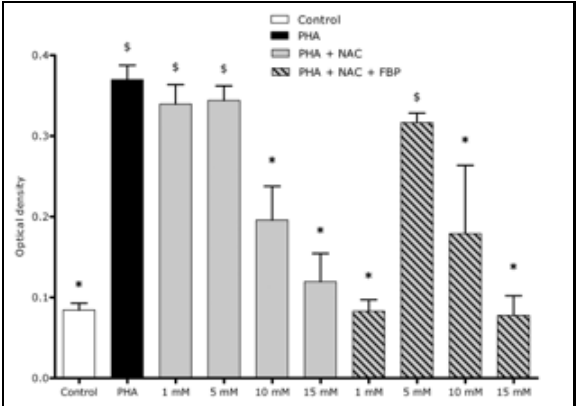
Figure 1 – NAC alone and associated with FBP (1,25 mM) immunomodulatory effects of in PHA stimulated T-lymphocytes. The results were evaluated by optical density in triplicate cultures and expressed as mean ± SEM NAC: N-acetylcysteine; FBP: fructose-1,6-bisphosphate; PHA: phytohemagglutinin; SEM: standard error about the mean ; $: a significant difference compared to the control group ( p < 0.05); *: a significant difference compared to the PHA group ( p < 0.05).